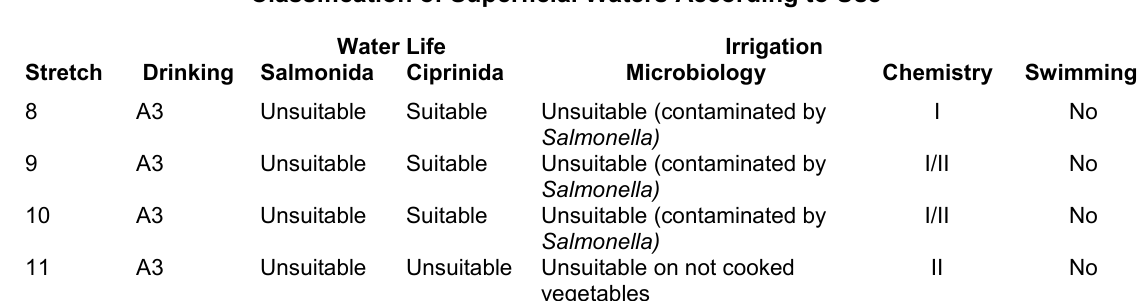
Classification of Superficial Waters According to